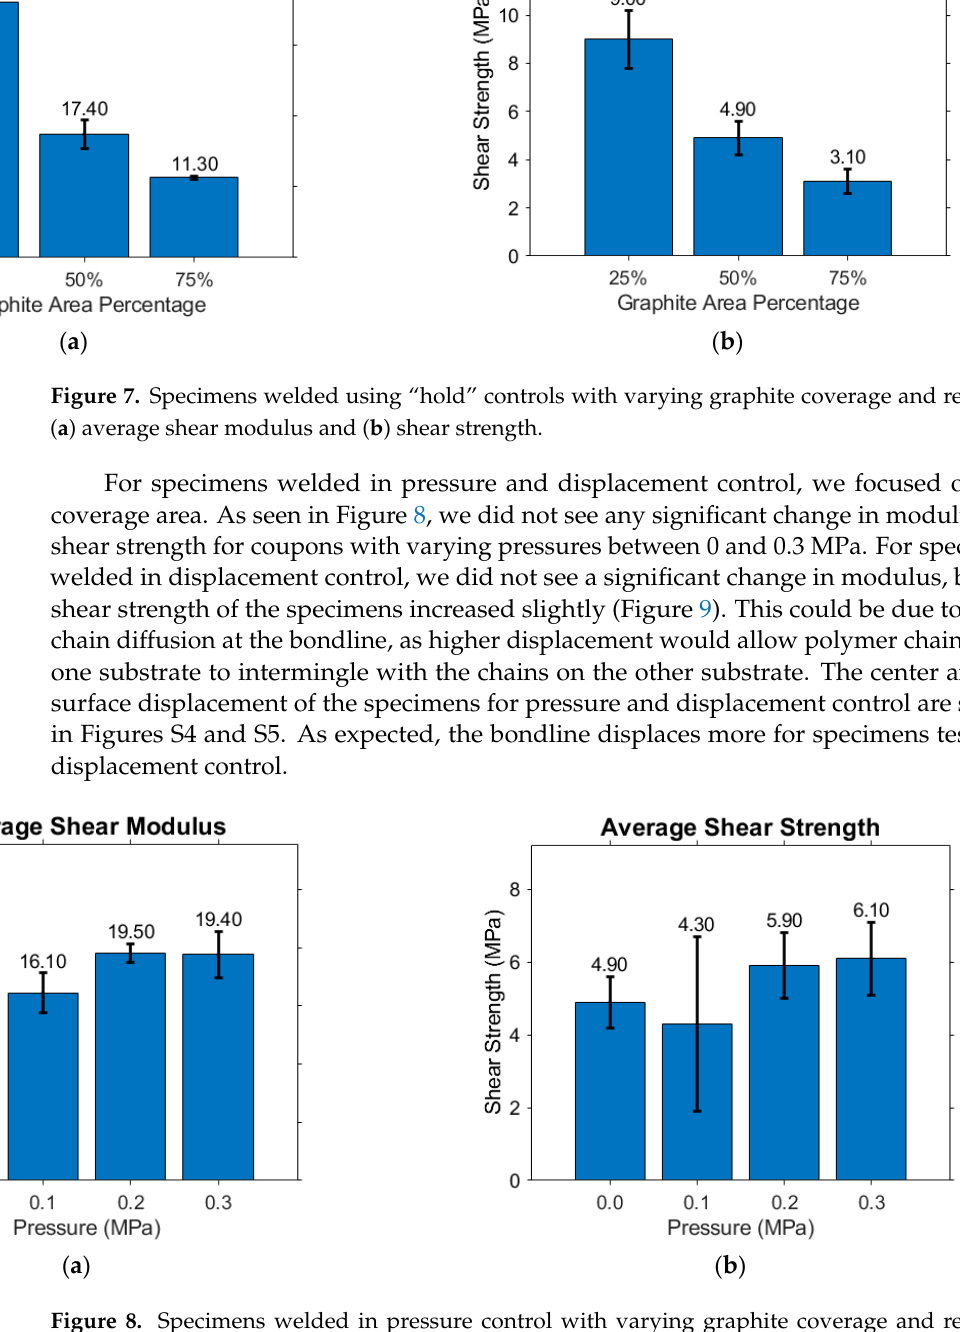
( b ) Figure 9. Specimens welded in displacement control with varying graphite coverage and resulting ( a ) average shear modulus and ( b ) shear strength. We see a slight increase in the shear strength for displacement-controlled specimens as compared to pressure-controlled specimens; this can be explained by examining the force and temperature evolution over time for these experiments. For pressure-controlled